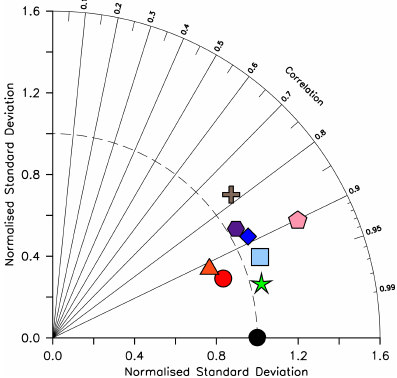
Figure 16. Taylor diagram (Taylor, 2001) of CMIP6 annual av- erage dissolved silicic acid distribution (in molSim − 3 ) for year 2014, normalized to the Garcia et al. (2014b) dataset. The dis- tance to the origin represents the normalized standard deviation. Normalized correlation with observations is read from the az- imuthal position. Perfect agreement with observations is a normal- ized standard deviation of 1 and a normalized correlation of 1. Models are KMBM3 (red circle), GFDL-ESM4 (green star; Krast- ing et al., 2018), CESM2 (light blue square; Danabasoglu, 2019), MPI-ESM1.2-LR (pink pentagon; Wieners et al., 2019), NorESM2- LM (brown plus; Seland et al., 2019), CMCC-ESM2 (orange tri- angle; Lovato et al., 2021), EC-Earth3-CC (blue diamond; EC- Earth Consortium, 2021) and IPSL-CM6A-LR (purple hexagon; Boucher et al., 2018). With the exception of KMBM3, the data for all models were obtained by mining the CMIP6 database (https:// esgf-node.llnl.gov/search/cmip6/) using the following search terms: CMIP/si/historical/annual output. Data were accessed between 1– 5 February